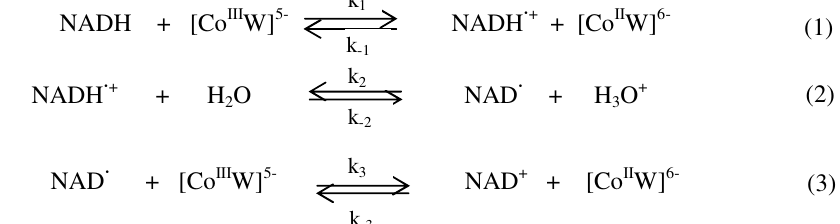
Figure 5 . Scan of reaction mixture with respect to time showing NAD + formation after 24